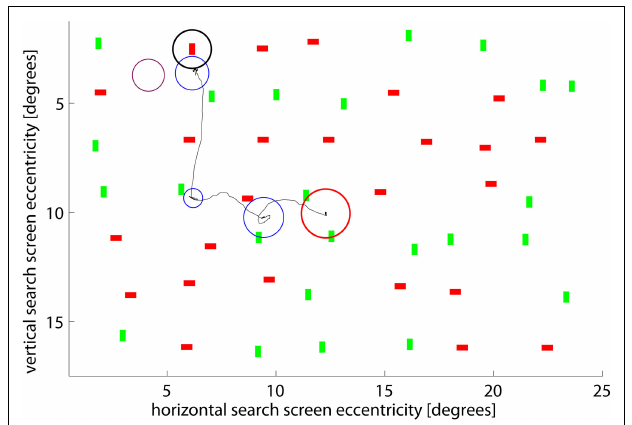
FIGURE 1 | Example search screen and scan path of one subject. The red circle marks the center of the screen, the black circle the location of the target (not shown to subjects). Blue circles show individual fi xations – their radii are proportional to the fi xation duration. A radius of 1.5 ° corresponds to 170 ms (shown in purple for comparison). The search was stopped after the subject fi xated close to the target (3rd fi xation). Screen eccentricity refers to the size of the objects, in units of visual angle, thus showing the size of the objects on the subjects’ retina rather than on the screen